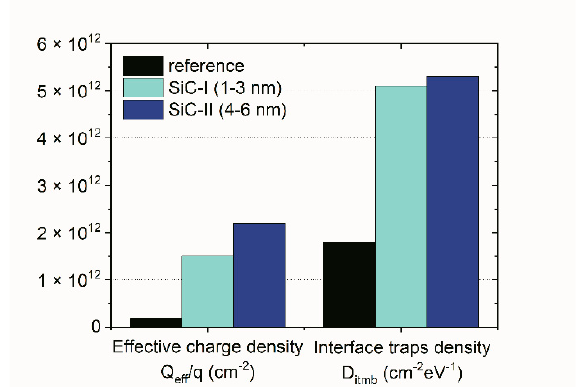
Figure 9. Extracted parameters showing the effective charge density (Q eff /q) and interface traps density in the middle of the silicon bandgap (D itmb ) for NC-MIS structures and reference MIS devices investigated in this work.